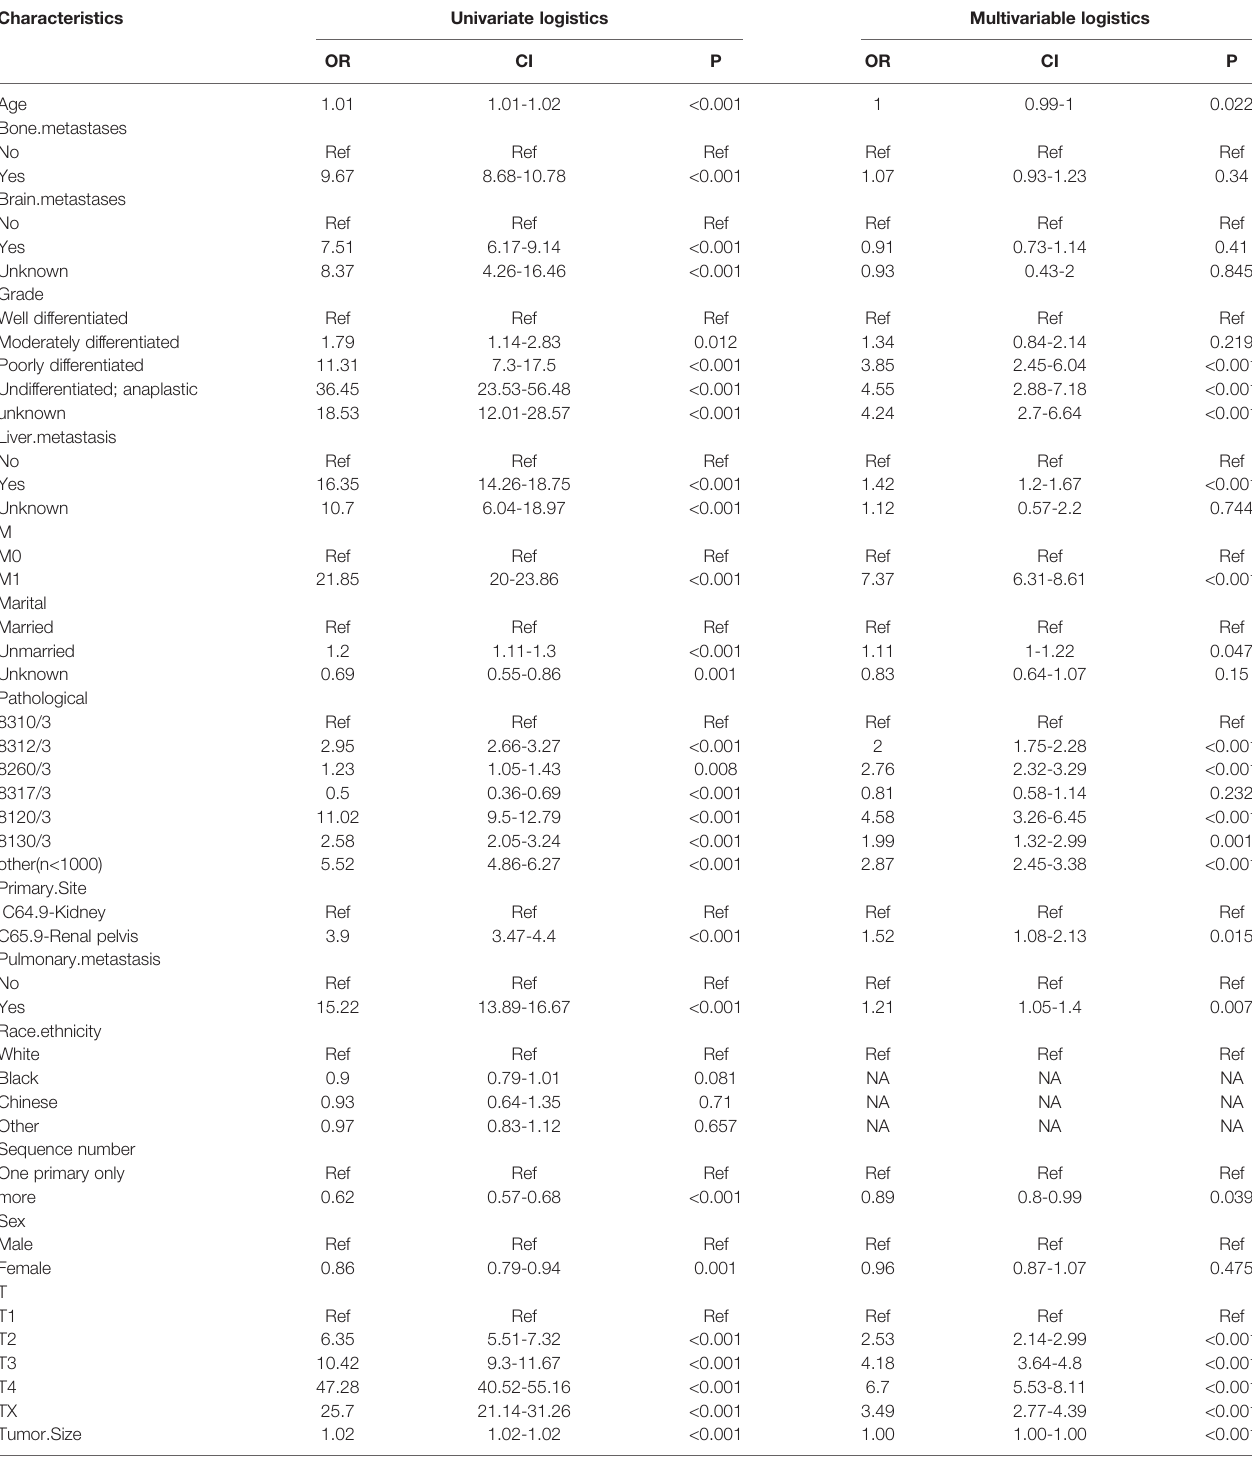
TABLE 3 | Univariate and multivariate Logistic regression for lymphatic metastasis of renal carcinoma.